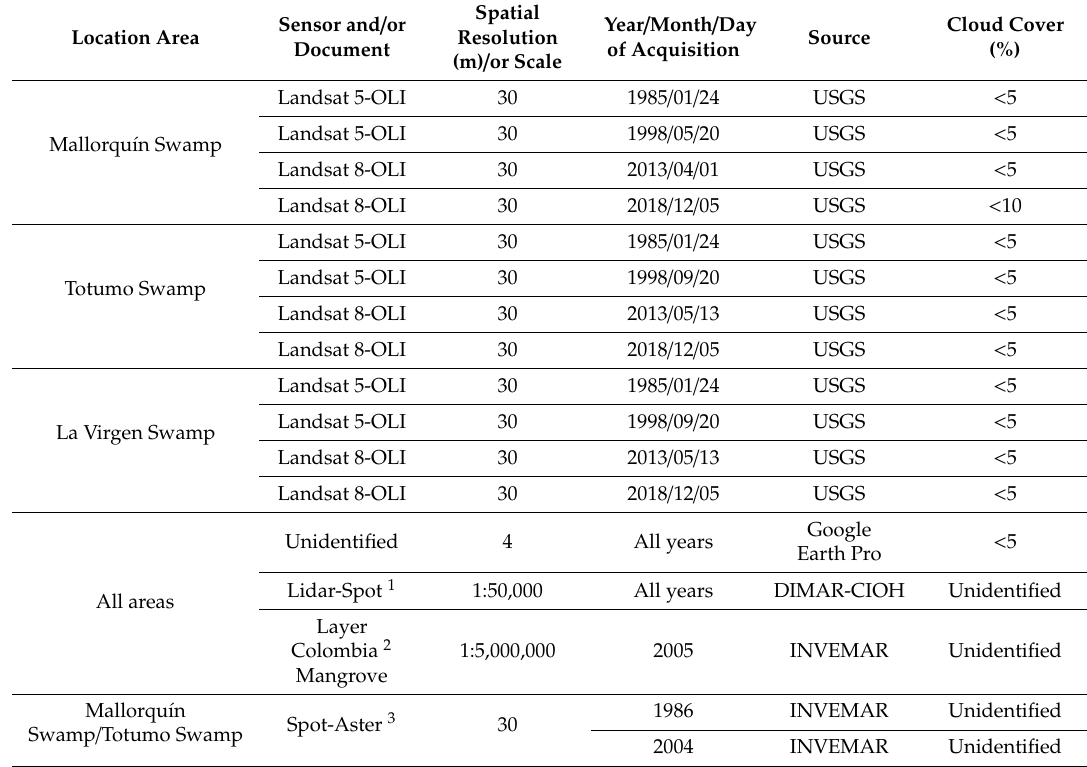
Table 1. Details of multispectral remote sensing data and other documents used in this